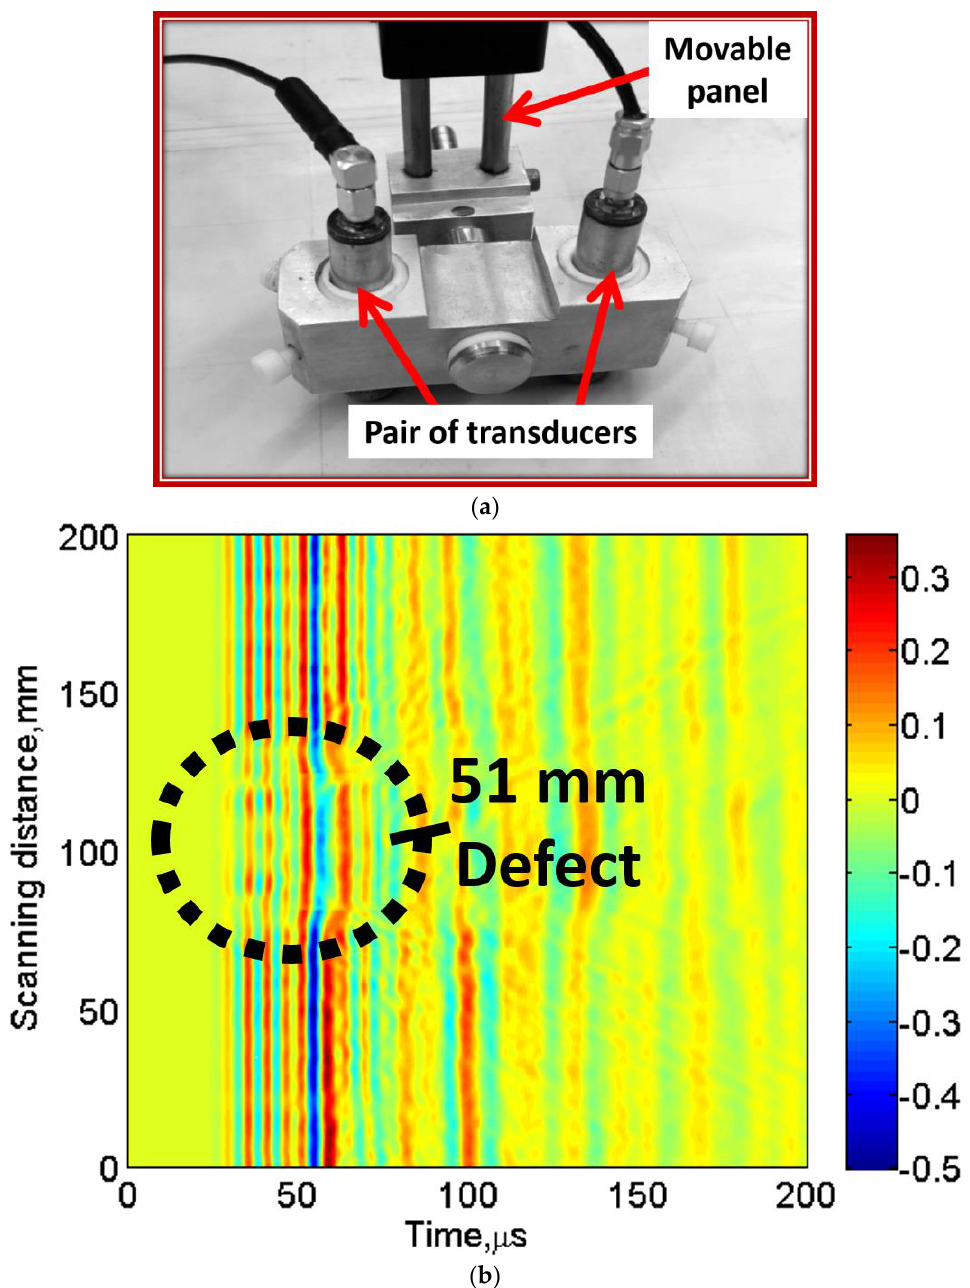
Figure 9. Experimental investigation of 51 mm defect located on GFRP sample: ( a ) photo view of special arrangement of contact-type transmitter–receiver pair mounted on a moving panel; ( b ) experimental B-scan showing 51 mm defect.